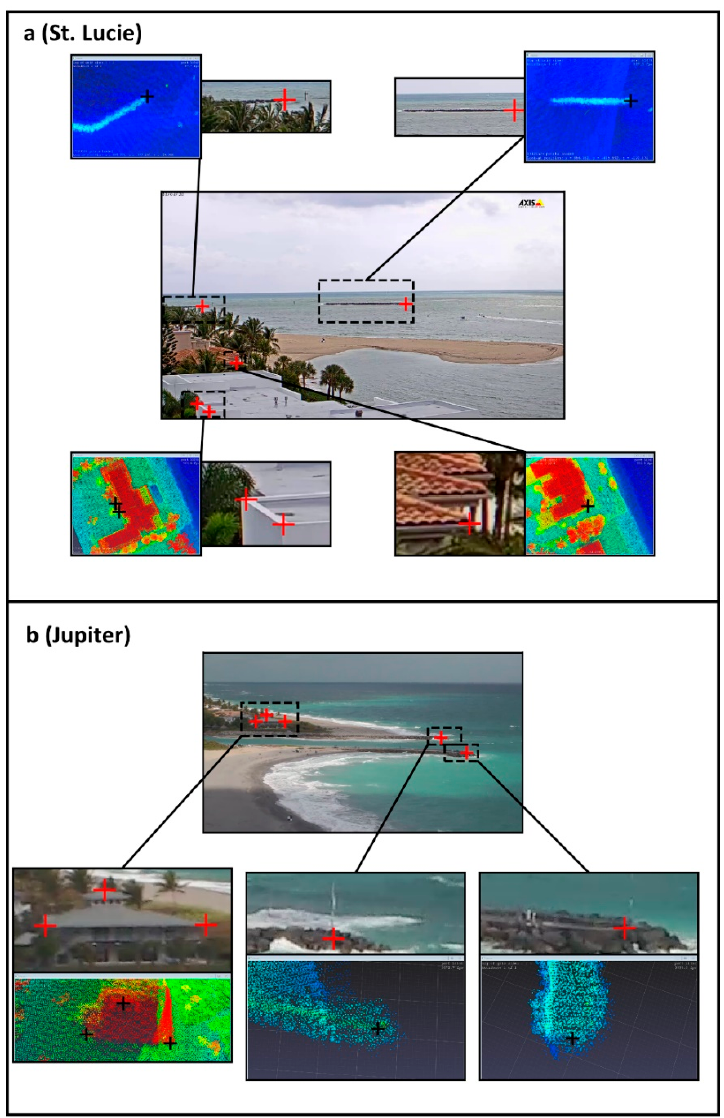
Figure 2. Remotely extracted ground control points at the St. Lucie ( a ) and Jupiter ( b ) cameras, as identified in the image and in lidar point clouds (lidar point clouds are colored by elevation).